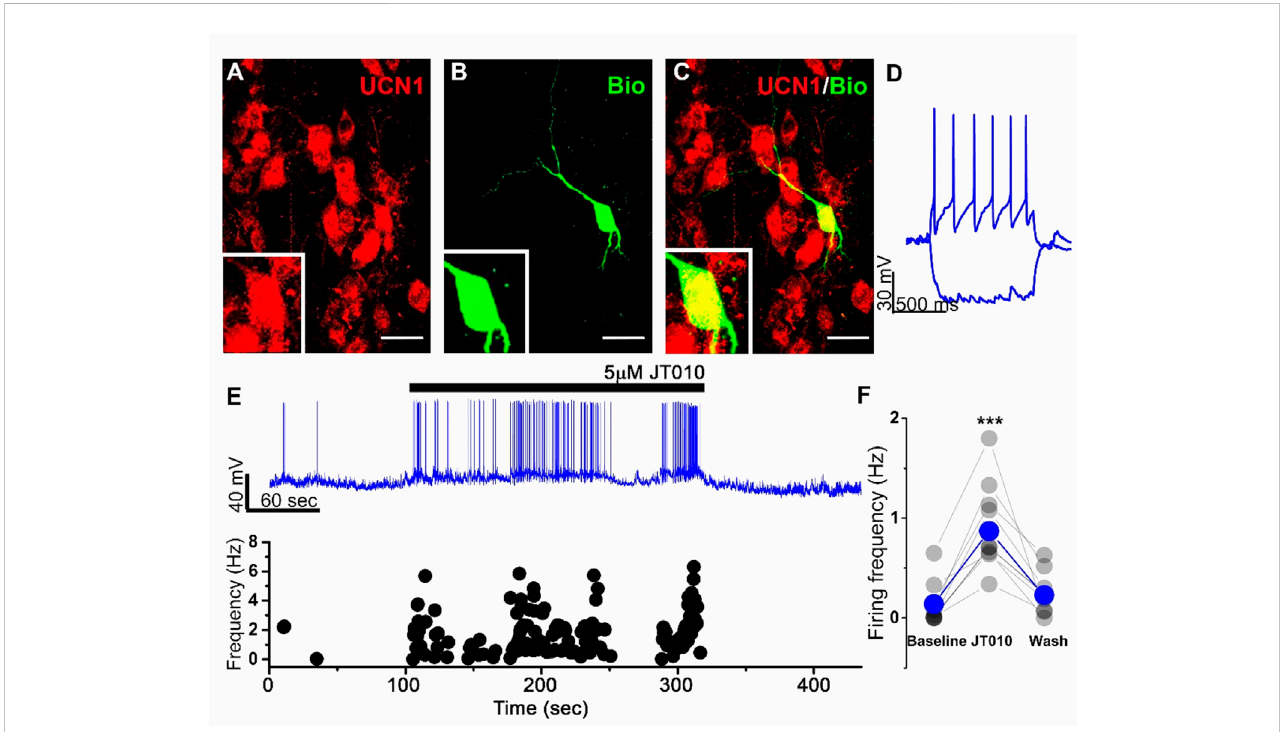
FIGURE 1 JT010 increases spontaneous fi ring frequency of UCN1-immunoreactive neurons in the EWcp nucleus. Representative confocal images of UCN1- immunoreactive (red) cells (A) and a biocytin (green) fi lled patched neuron (B) and the merged image (C) . Insets shows the magni fi ed soma of the patched neuron. Scale bars: 40 µm. Response of the recorded cell (D) to 1 s current injection ( − 100 and +100 pA). Representative current clamp recordings (E, upper panel) showing the spontaneous activity of UCN1-immunoreactive neuron. Black bar represents JT010 application (5 µM). Instantaneous fi ring frequency (E) , lower panel] of each action potential in the upper recording is plotted. Statistics (F) showing the fi ring frequency at baseline (2 min before drug application) during JT010 application and after washing out the drug ( n = 9 from 4 mice). *** p < .001; Tukey ’ s post hoc test upon one-way ANOVA.